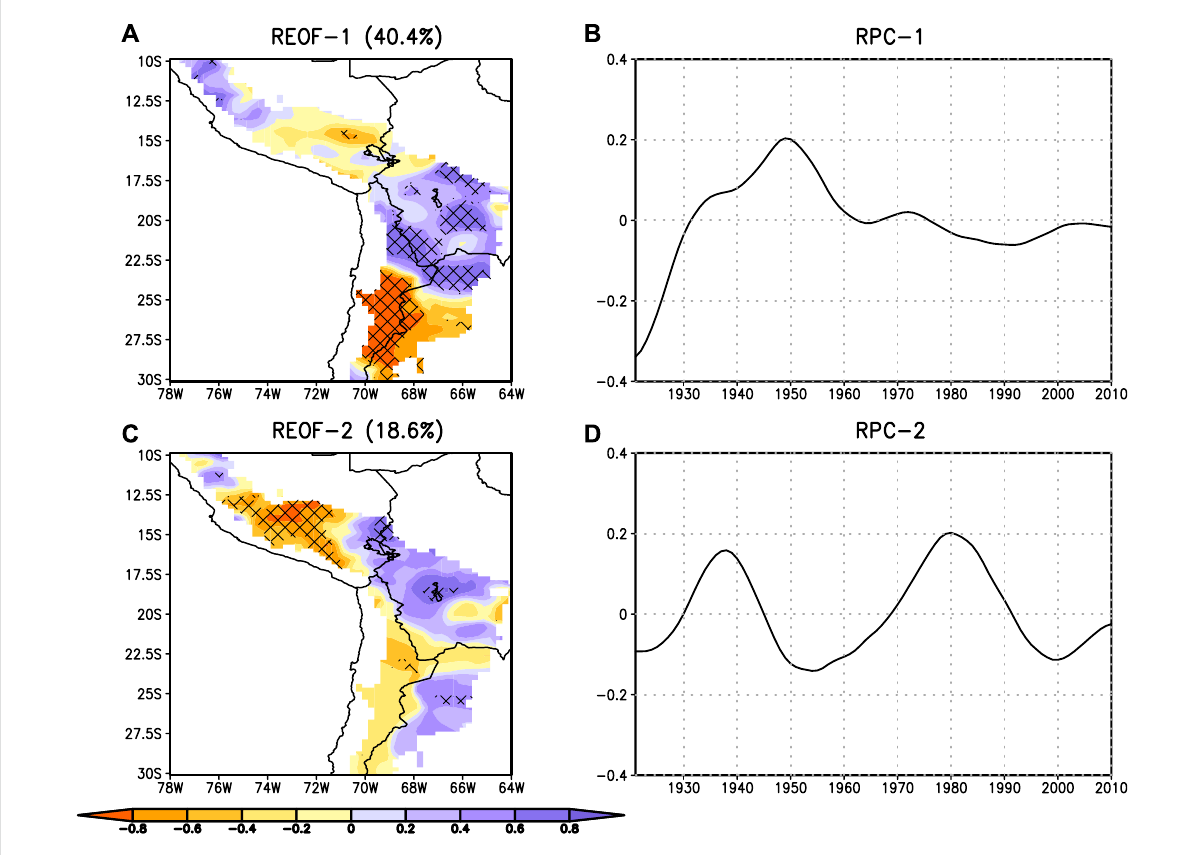
FIGURE 10 (A) The fi rstREOF1ofinterdecadalDJFprecipitationovertheCentralAndes.Numberinparenthesisindicatestotalvarianceexplained.Hatching indicates regions with a statistically signi fi cant correlation between the local REOF loading and the corresponding RPC at the 95% con fi dence level. Note that analysis is limited to regions above 1,500 m asl. (C) As in (A) but for REOF 2. (B) Time series of RPC1 of interdecadal DJF precipitation over the Central Andes. (D) As in (B) but for RPC2. Analysis based on the 1921 – 2010